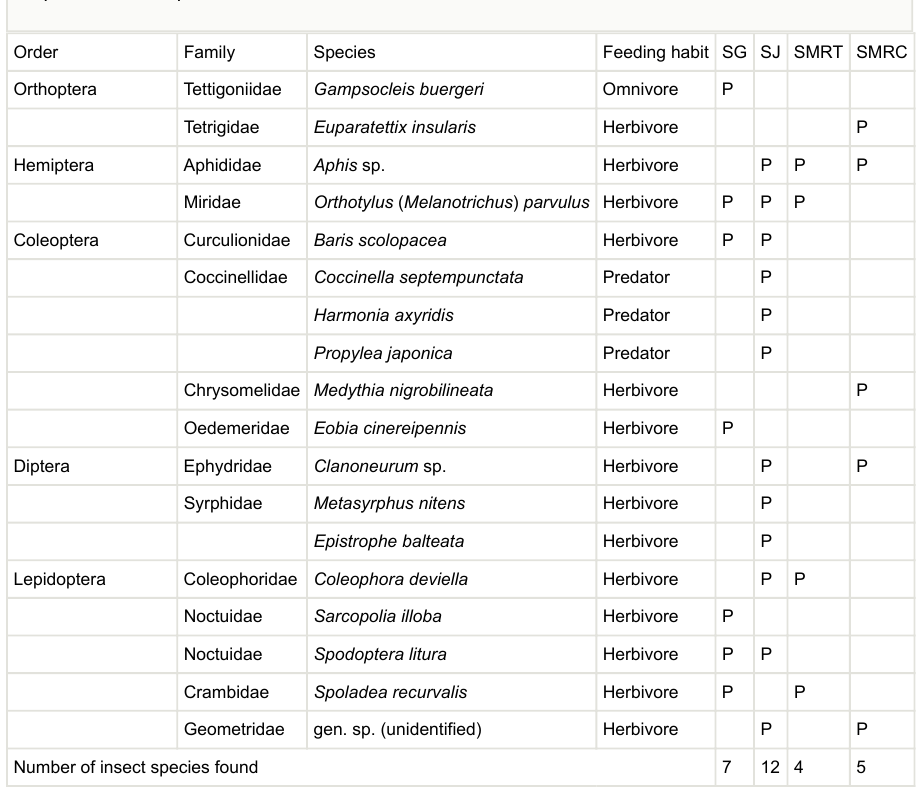
Table 1. Insects found on Suaeda species and their feeding habit. Abbreviations of Suaeda plants are as follows: SG, S. glauca ; SJ, S. japonica ; SMRT, S. maritima asiatica ; and SMRC, S. maracosperma . P: present on the